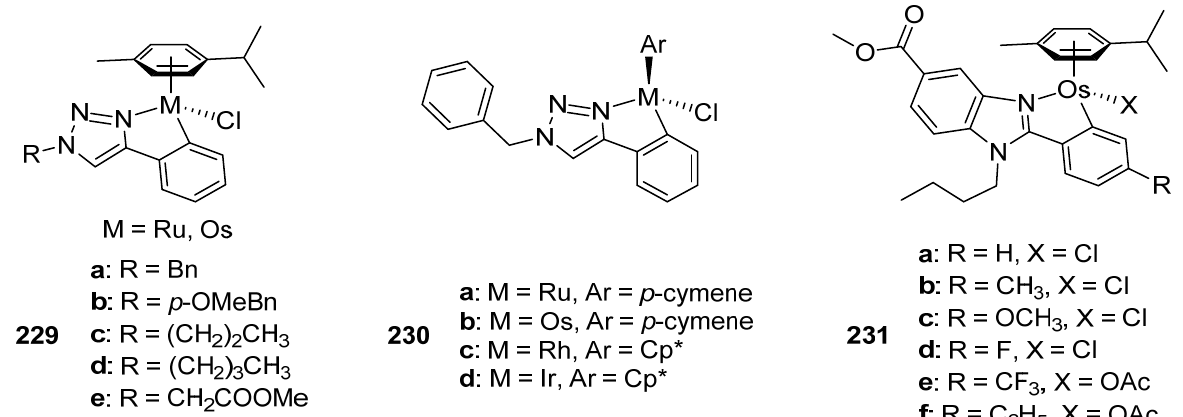
Figure 56. Series of cyclometalated osmium complexes tested in the in vitro cell growth inhibition in A172 glioblastoma cell line.